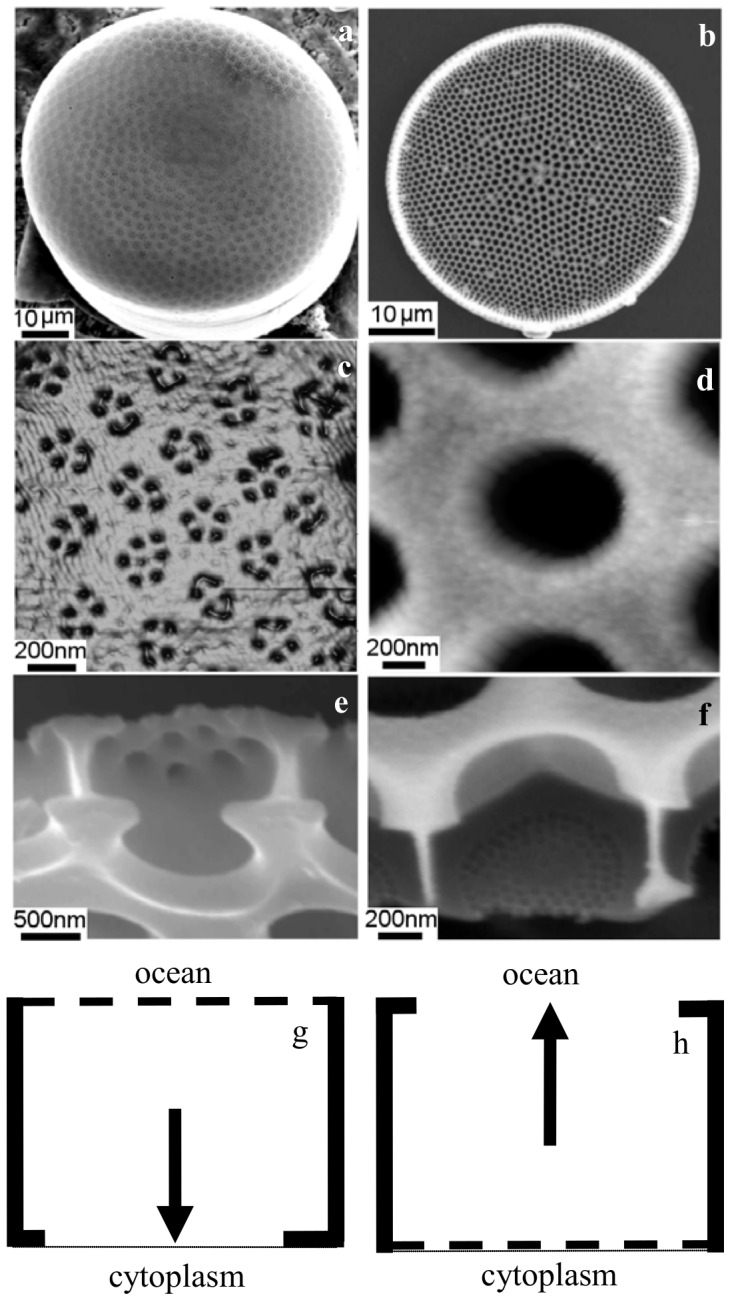
The diatoms Coscinodiscus sp. (a–c) and T. eccentrica (d–f) with close ups of their outer surfaces (b and e) and cut away sections of the frustule showing trapping (c) and open (f) morphologies.A schematic shows the effects of trapping (g) and open (h) morphologies, where the net nutrient flux (arrows) after a nutrient pulse passes is inwards (g) or outwards (h). The diatoms are 60 and 30 µm across. The large openings are approximately 1 µm and the small openings are 40 nm. The latter are expanded here for graphical clarity. Additional siliceous membranes with intermediate pore sizes may be present in some forms (c).